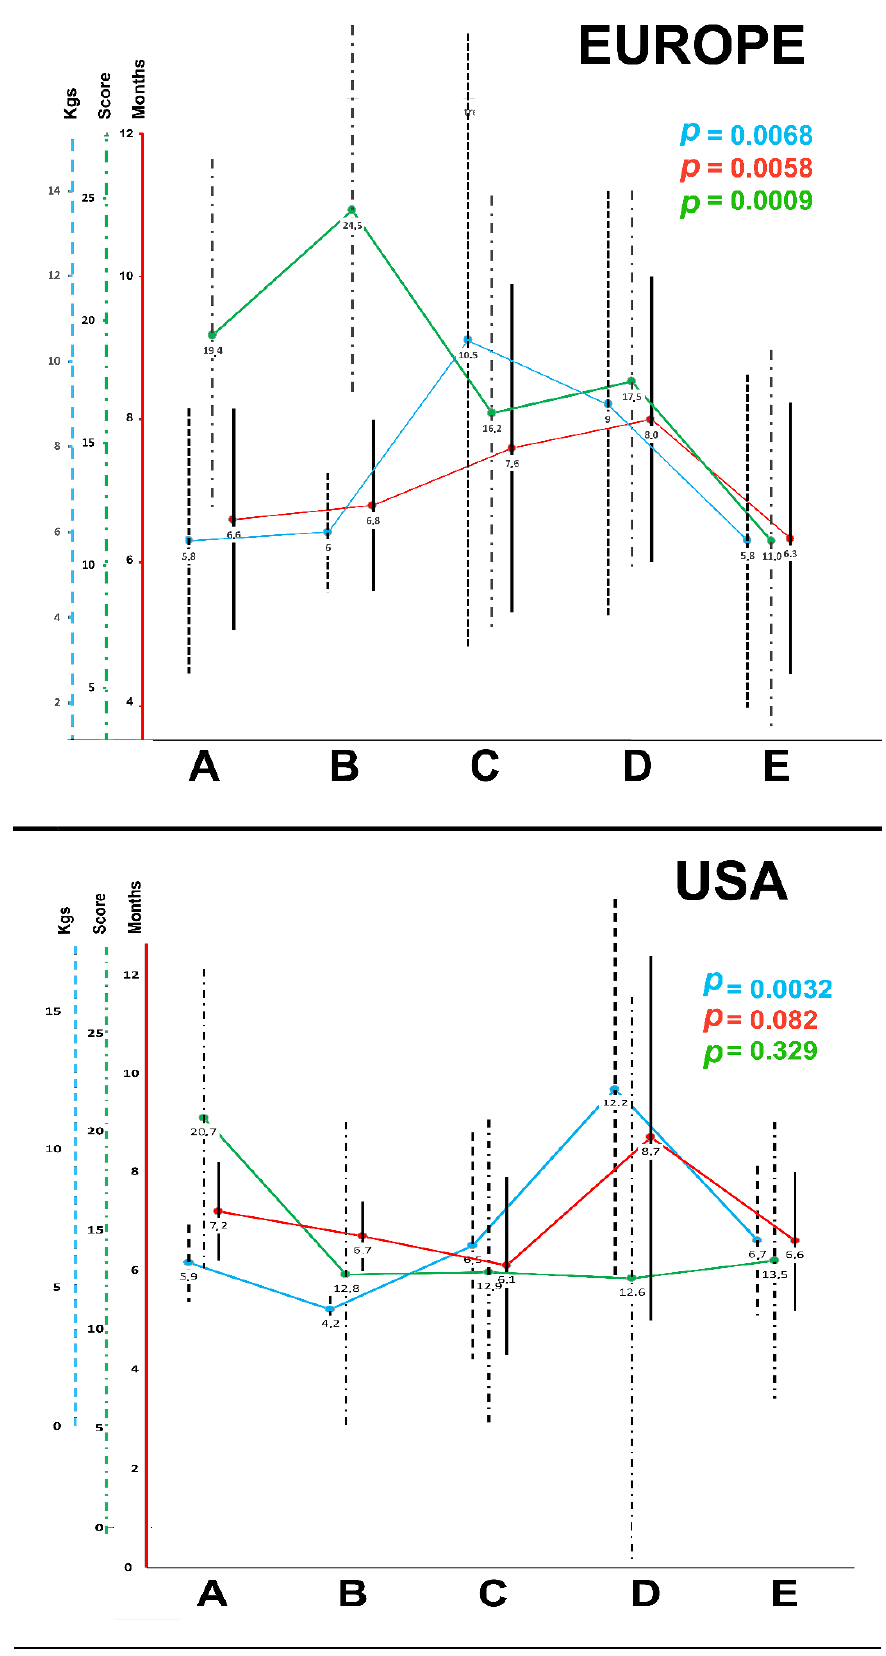
Figure 2. Patient characteristics at assessment for liver transplantation, as per initial management of biliary atresia. Age, weight and PELD score at assessment for liver transplantation (the dots represent the median value, with the black vertical bars representing SD): distribution per